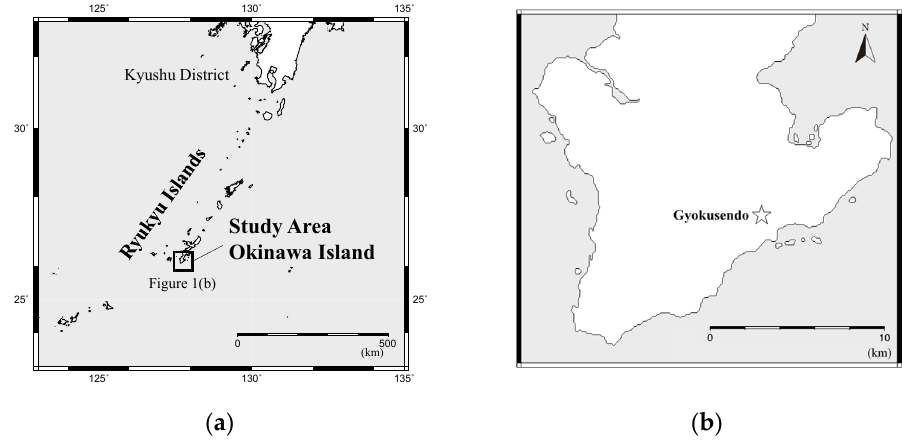
Figure 1. Maps showing the study area ( a ) and Gyokusen-do Cave ( b ).